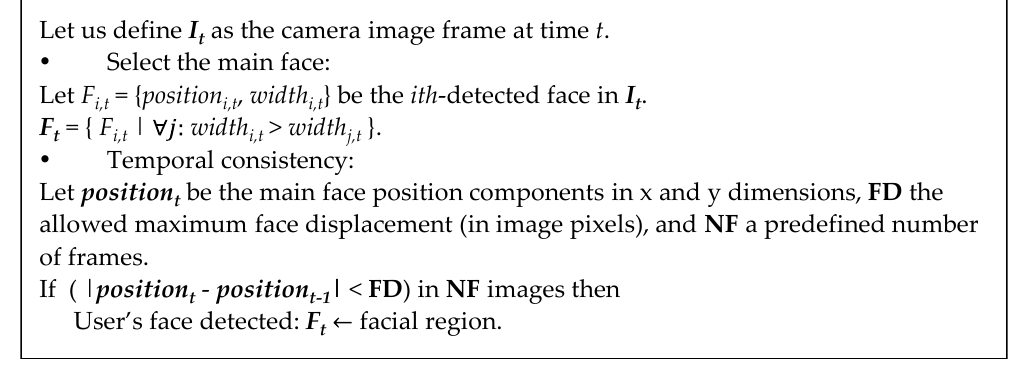
Figure 3. Facial region detection algorithm carried out in the User detection stage.